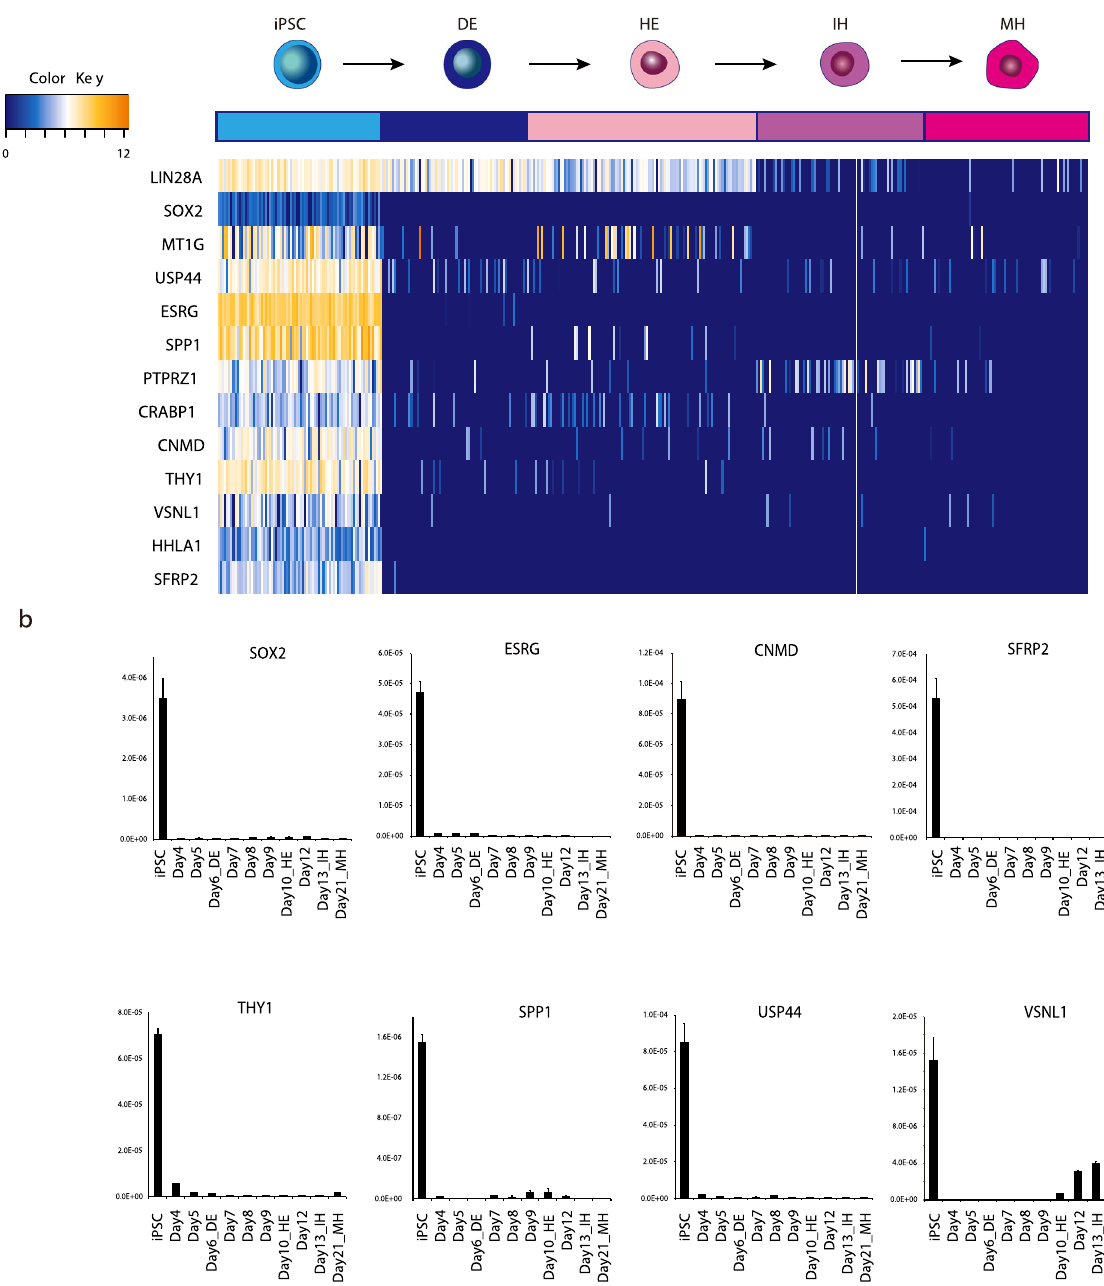
Twelve genes were selected as illustrated in Fig. 2a which expressed highly, specifically, and abundantly in iPSC. Marker gene expression was confirmed using quantitative reverse transcription-polymerase chain reaction (qPCR), and ESRG (Embryonic Stem Cell Related) , SFRP2 (Secreted Frizzled Related Protein 2) , CNMD(Chondromodulin, also referred to as LECT1) , SOX2 (SRY-Box 2) , THY1 (Thy-1 Cell Surface Antigen) , USP44 (Ubiquitin Specific Peptidase 44) , VSNL1 (Visinin Like 1) , and SPP1 (Secreted Phosphoprotein 1) were selected for further analyses (Fig. 2b). Marker genes were also checked using several iPSC lines to exclude clone specific variations. We confirmed that the genes were down-regulated considerably following the stimulation of differentiation in several other iPSC lines (Fig. S2). We estimated the actual RNA count of these markers in one